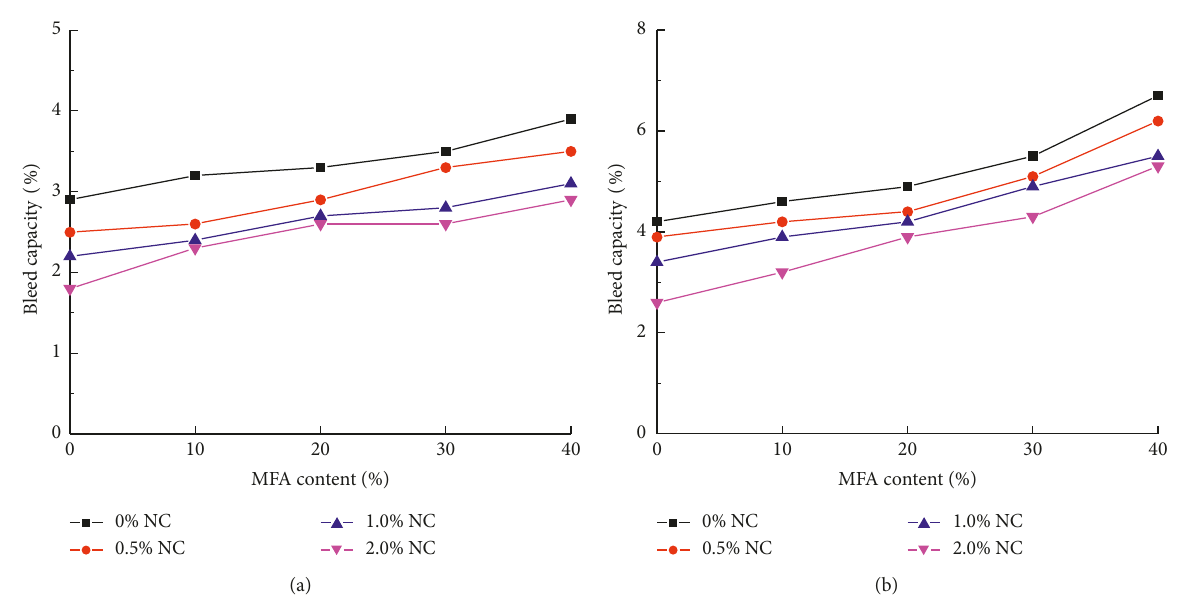
Figure 7: Bleed capacity of fresh grouts with a W/S ratio of 1.2: (a) 0% SP; (b) 1.5% SP.